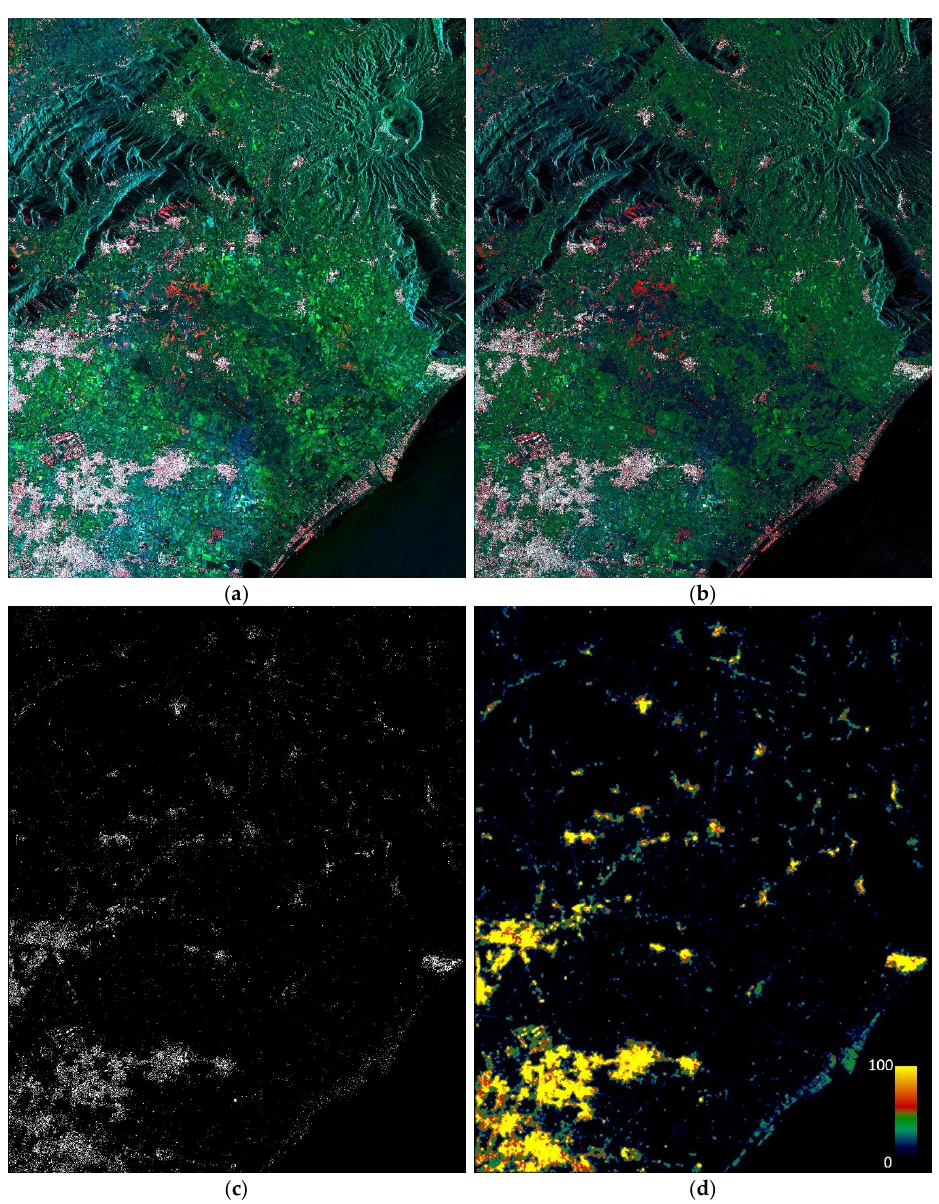
Figure 2. Generation of the coarse urban area map. ( a ) RGB Level-1α product. ( b ) 16-category pre- classification map obtained through SOM clustering. ( c ) Built-up feature map obtained by isolation of the white and red classes in the clustered product. ( d ) Urban density map generated by averaging the density maps obtained by sliding two windows of different size on the binary mask depicted in ( c ).